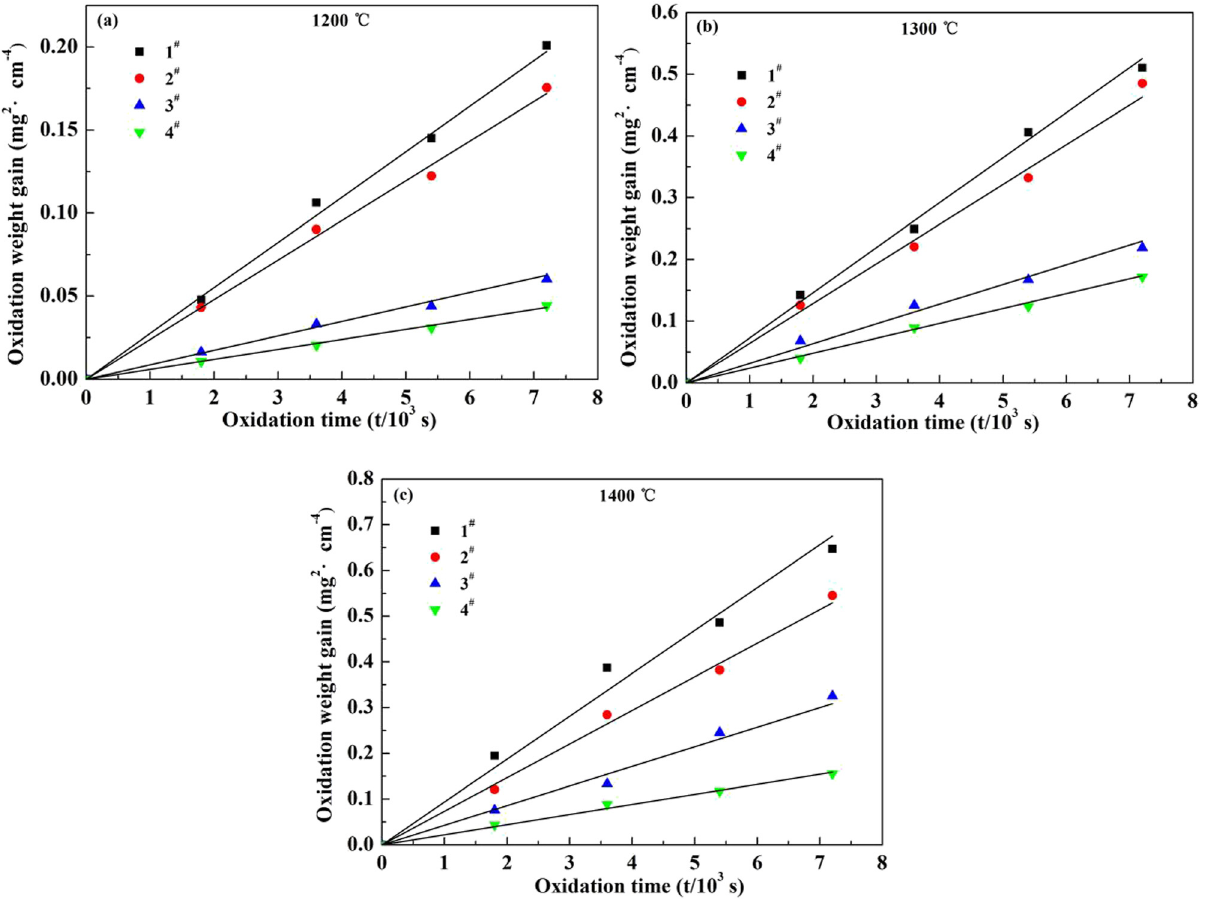
Figure 8: Square of specific weight gains as a function of oxidation time for Si 4 Al 2 O 2 N 6 powder oxidized at different temperatures: ( a ) 1200°C, ( b ) 1300°C, and ( c ) 1400°C. Table 2: Calculated oxidation rate constant ( K p ) for Si 4 Al 2 O 2 N 6 powder oxidized at 1,200 – 1,400°C mg 2 cm − 4 s − 1